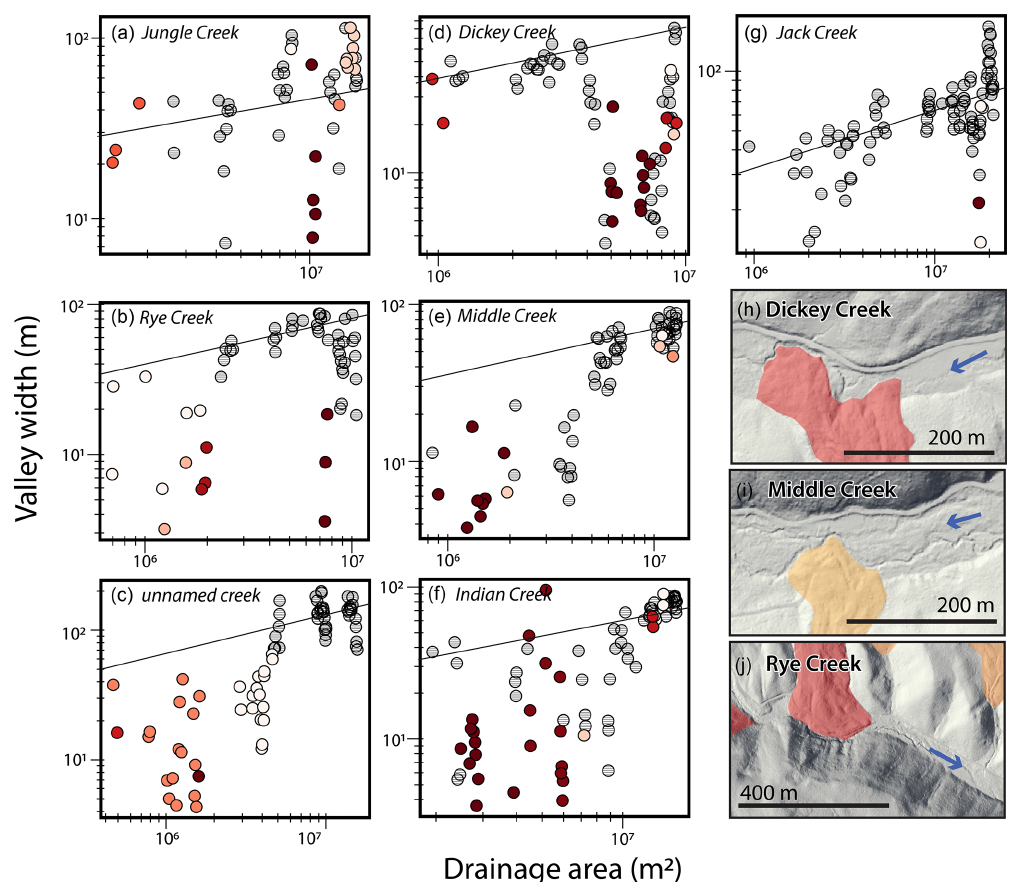
Figure 4. Valley width of the North Fork tributaries compared with upstream contributing drainage area (a–g) . Black lines show a power law relationship with exponent 0.3 (Schanz and Montgomery, 2016; Clubb et al., 2022). Tributaries are arranged counterclockwise from the northwest (see Fig. 1 for locations). Colored circles indicate valley width measurements where one valley wall is an earthflow; colors reflect MADstd relative to earthflows within that tributary in which red are high MADstd and light pink are low MADstd. Panels (h) – (j) show examples of earthflows interacting with valley bottoms; earthflow color corresponds to MADstd value using the same color scheme as panels (a) – (g) . Blue arrows show the direction of the water